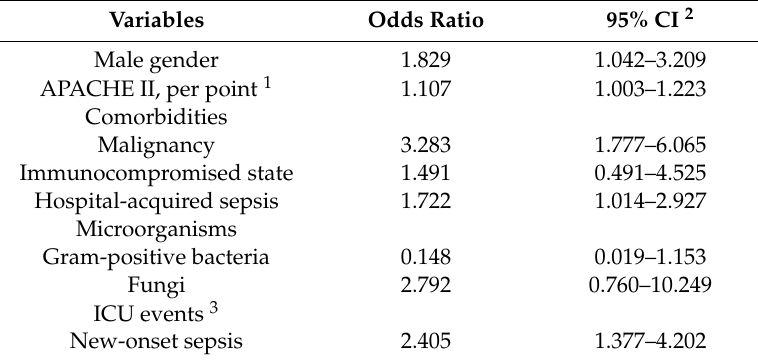
Table 4. Multivariate model for factors associated with in-hospital